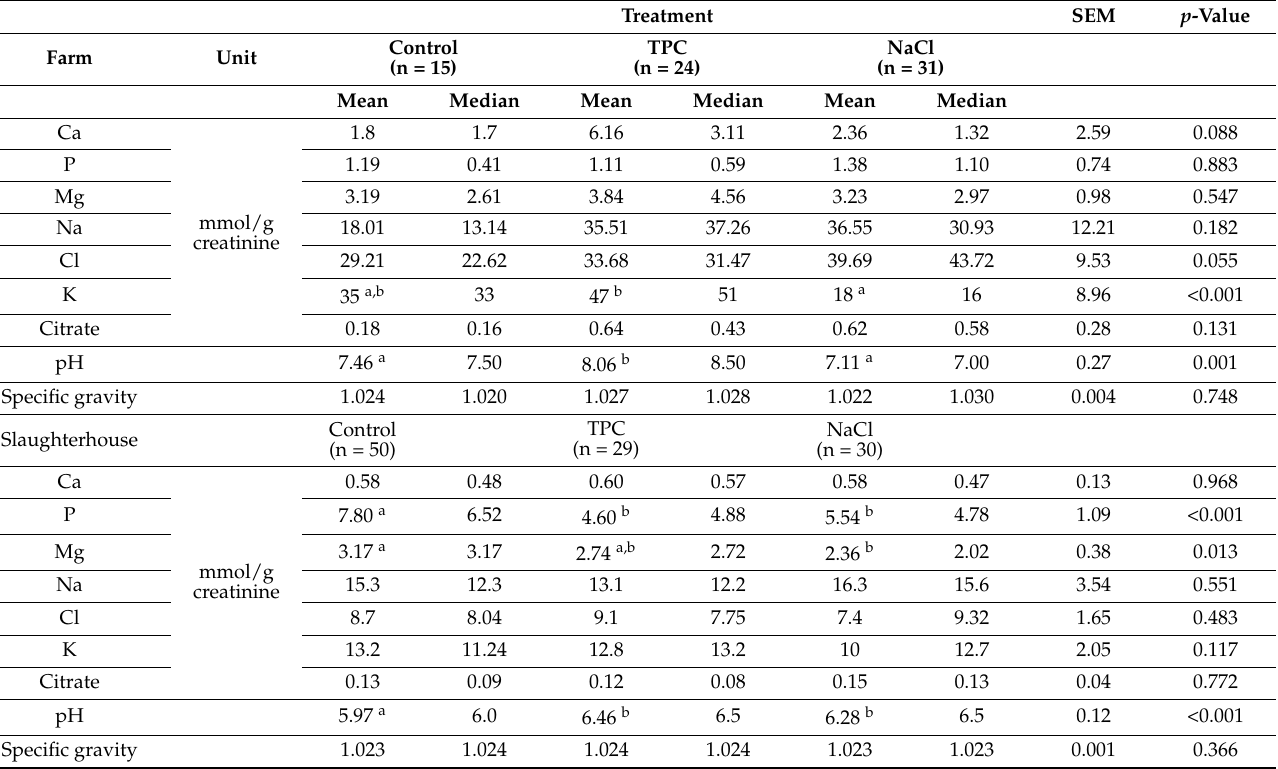
Table 7. Results of urinalysis A of samples taken at the farm and in the slaughterhouse from fattening pigs receiving three dietary treatments: the control group (control) received the normal feed used on the farm, the tripotassium citrate (TPC) and the sodium chloride (NaCl) groups received the normal feed supplemented with 0.25% TPC and 0.20% NaCl, respectively. Treatment SEM p